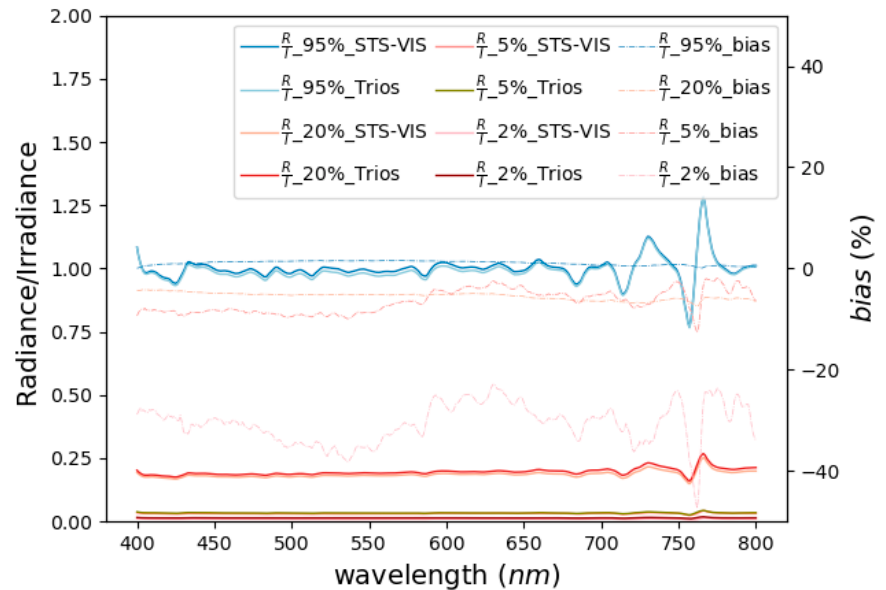
Figure 5. Diffuse reflectance plate results with bias plots for 95%, 20%, 5% and 2% measurements using Trios and